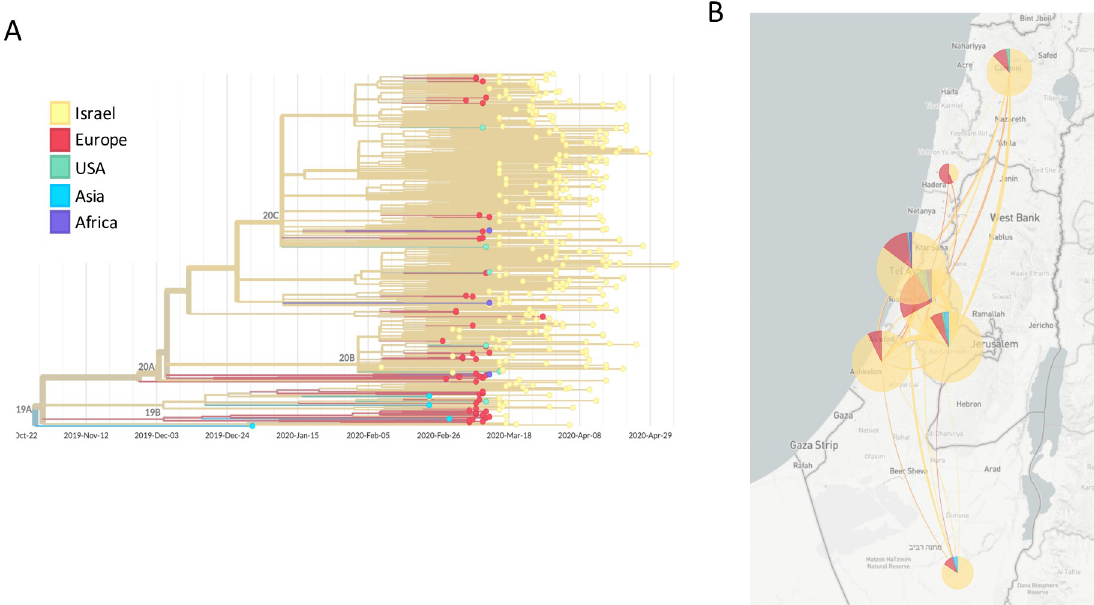
Fig 1. SARS-CoV-2 genomic epidemiology of samples imported and circulating in Israel. (A) time-resolved phylogenetic tree representing 372 imported and early circulating samples sequenced in Israel. Samples are colored according to their origin: Israel circulating samples in yellow, and imported samples from Europe, USA, Asia (China-reference sequence, Japan) and Africa (Egypt) in red, green, blue and purple, respectively. SARS-CoV-2 clades are noted by each relevant branch. (B) Distribution of imported and circulating samples across districts in Israel.